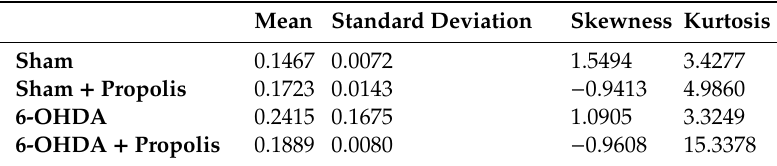
Figure 7. Representative striatum images of tyrosine hydroxylase (TH)-immunoreactive sections. TH- positive striatal fibers in ( A ) sham; ( B ) 6-OHDA; ( C ) sham+P; ( D ) 6-OHDA+P.